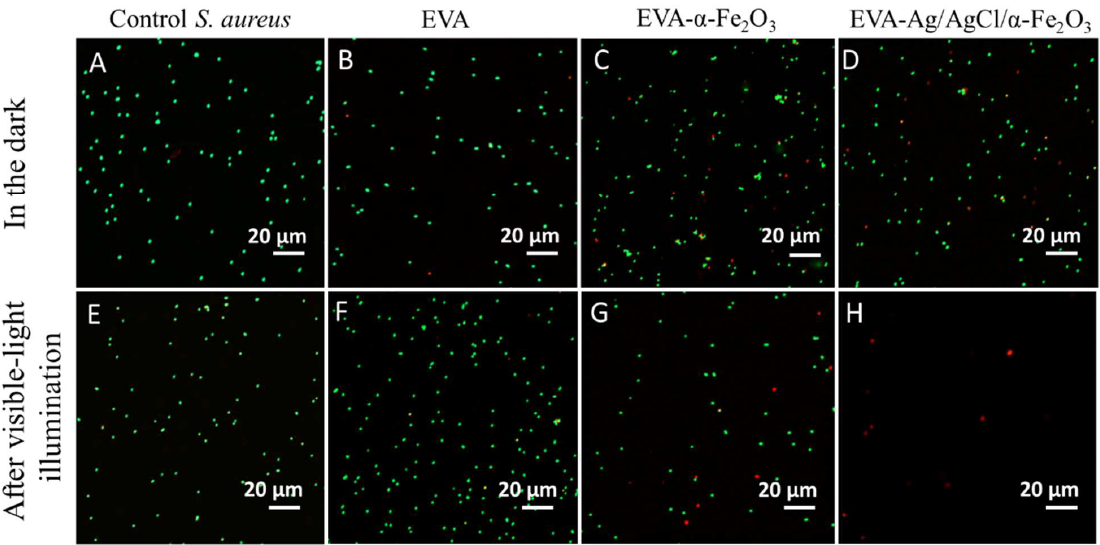
Figure 7. Representative Confocal Laser Scanning Microscopy (CLSM) images of Staphylococcus aureus suspension after 30 min exposure to the different surfaces in the dark ( A – D ) and under the visible-light illumination ( E – H ): viable cells—green (Syto9); dead or membrane damaged cells—red (PI). Scale bars represent 20 µmImages of bacteria growth test in tubes can be found in the Supplementary Material (Figure S2).